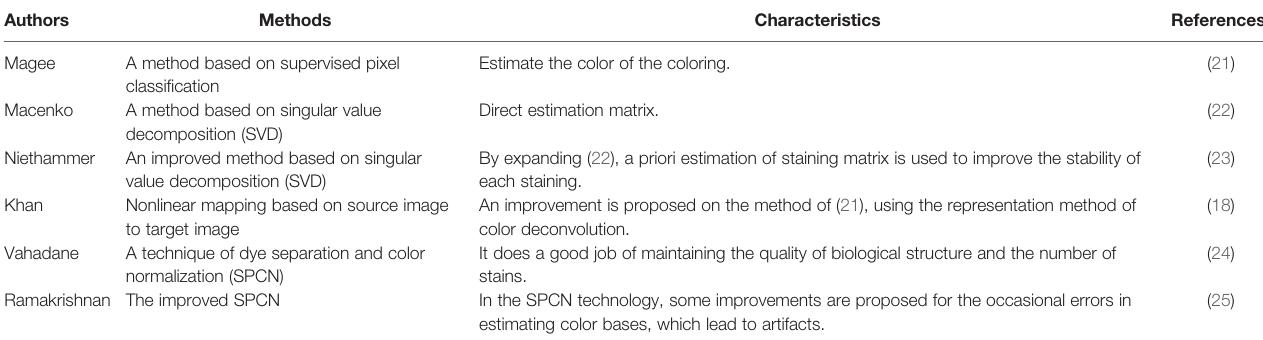
TABLE 1 | A summary of color normalization methods.